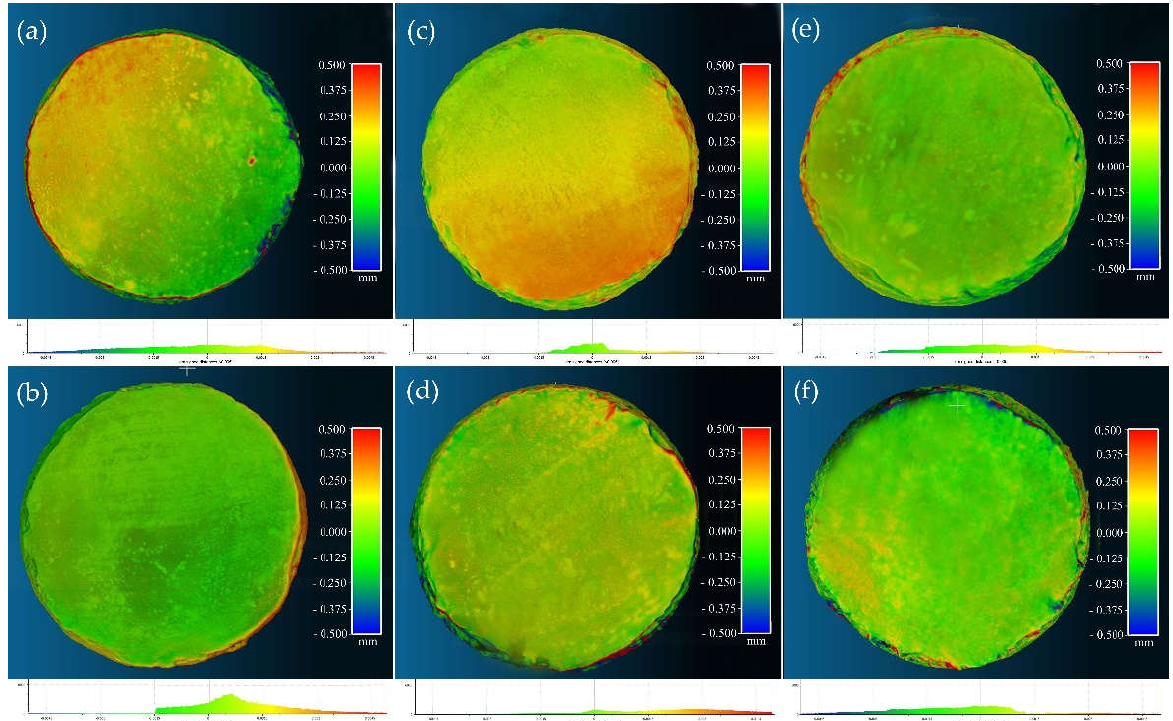
Figure 5. Rough quantification of the thickness of the whitish deposits removed in those specimens cleaned with rigid gels; the green areas are those in which the result of the treatment was hardly noticeable, and the yellow and red areas corresponded to those in which the treatment has been more noticeable: ( a ) AG1; ( b ) AG2; ( c ) ED1; ( d ) ED2; ( e ) AC1; ( f ) AC2.